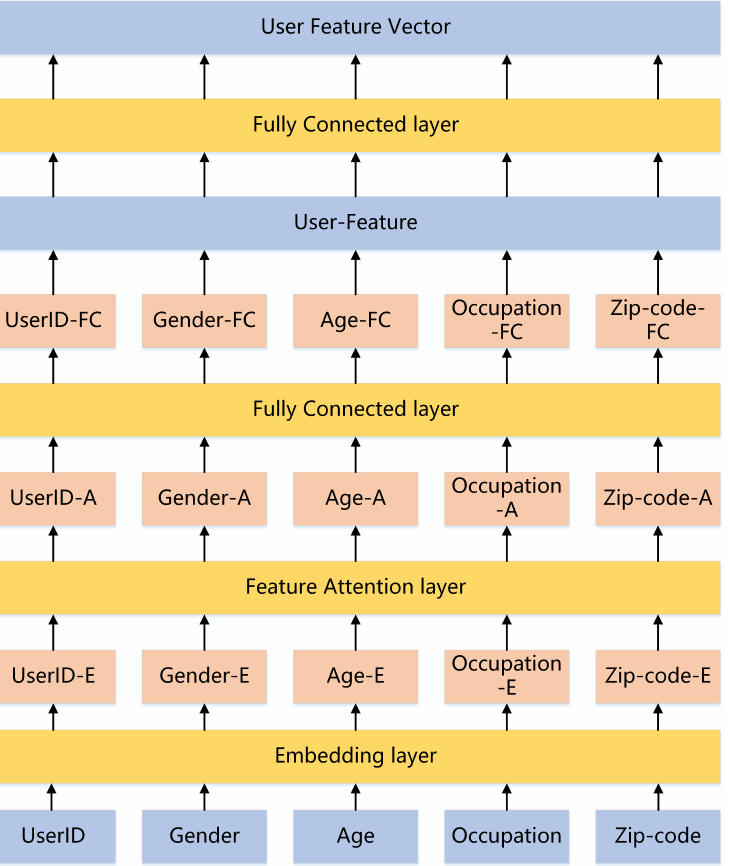
Figure 2. User network structure diagram. User features are sequentially passed through the embedding layer, feature attention layer, and fully connected layer to generate user feature